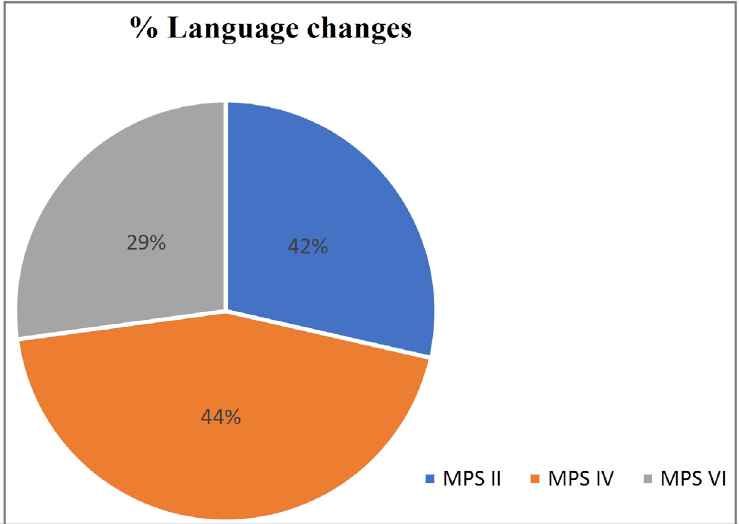
Figure 2. Percentage of changes in language. It is observed that that in MPS II and IV there is a higher percentage of change in language, compared to MPS VI, however it is important to take into account the number of participating patients for this mucopolysaccharidosis